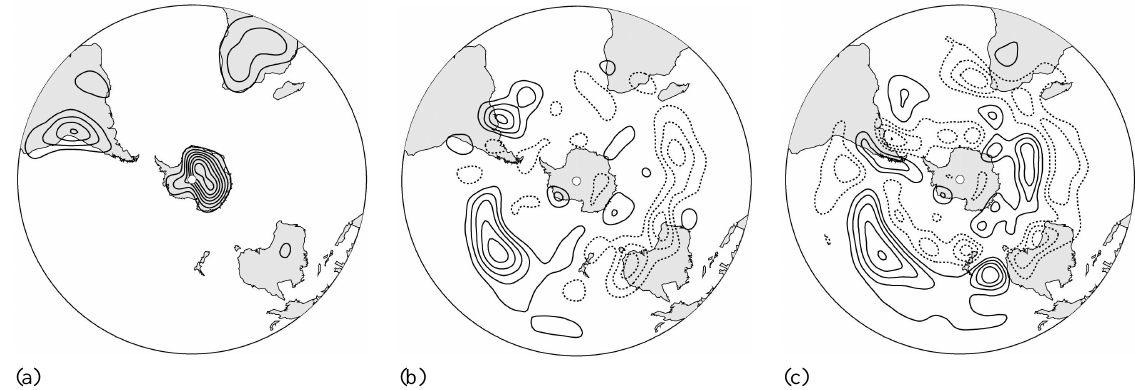
Fig. 1. (a) T21 topography of the Southern Hemisphere. Contour interval is 500m. (b) Non-zonal part of austral wintertime (JJA) extra- tropical diabatic heating at 300hPa derived from NCEP-NCAR reanalysis data and used in the atmospheric module. Contour interval is 0.25Kday − 1 without zero line. Negative values are dashed. (c) The same as in the middle, but for